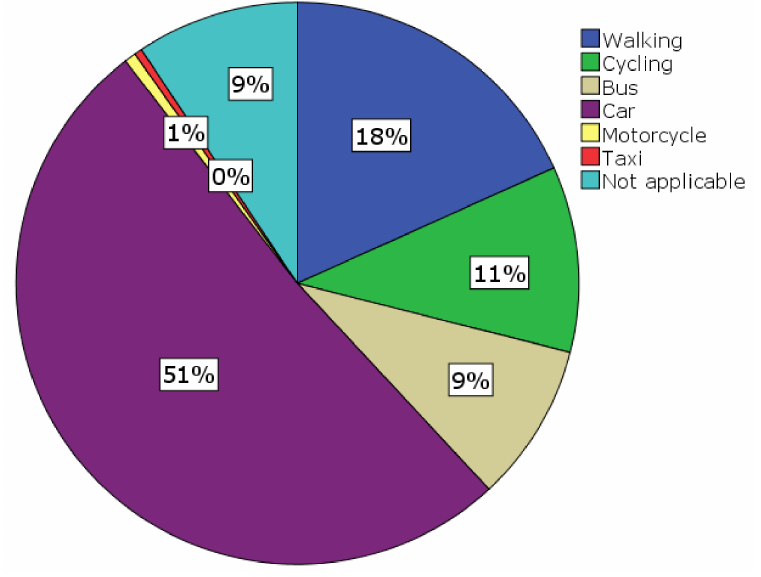
Figure 2. How people living in Galway travel to work ( results from this study